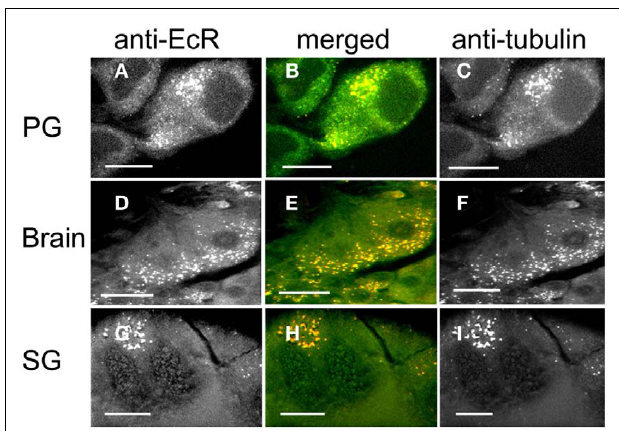
FIGURE 6 | PG cells (A–C), brain neurons (D–F), and SG cells (G–I) pre-treated with colchicine to disrupt MTs and double-labeled with anti-EcR (left column, green) and anti-tubulin (right column, red). Co-localization is shown as yellow/orange in the merged images of left and right in the middle column. Note the disruption of MTs in (C,F,I) , which appear as fluorescent specks and re-distribution of tubulin fluorescence. Co-localization is retained after colchicine treatment (B,E,H) . Scale bars = 10 μ m.